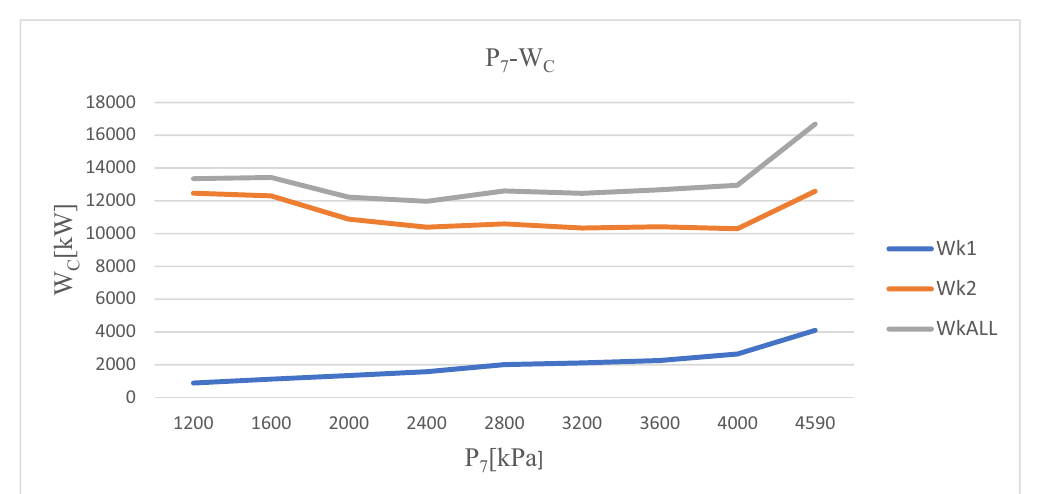
Figure 3: W C1 , W C2 , powers, and total compressor W kAll power curves of the whole cycle obtained for di ff erent output pressures at which the fi rst - stage compressor of the vapor compression two - stage cascade cryogenic cycle can